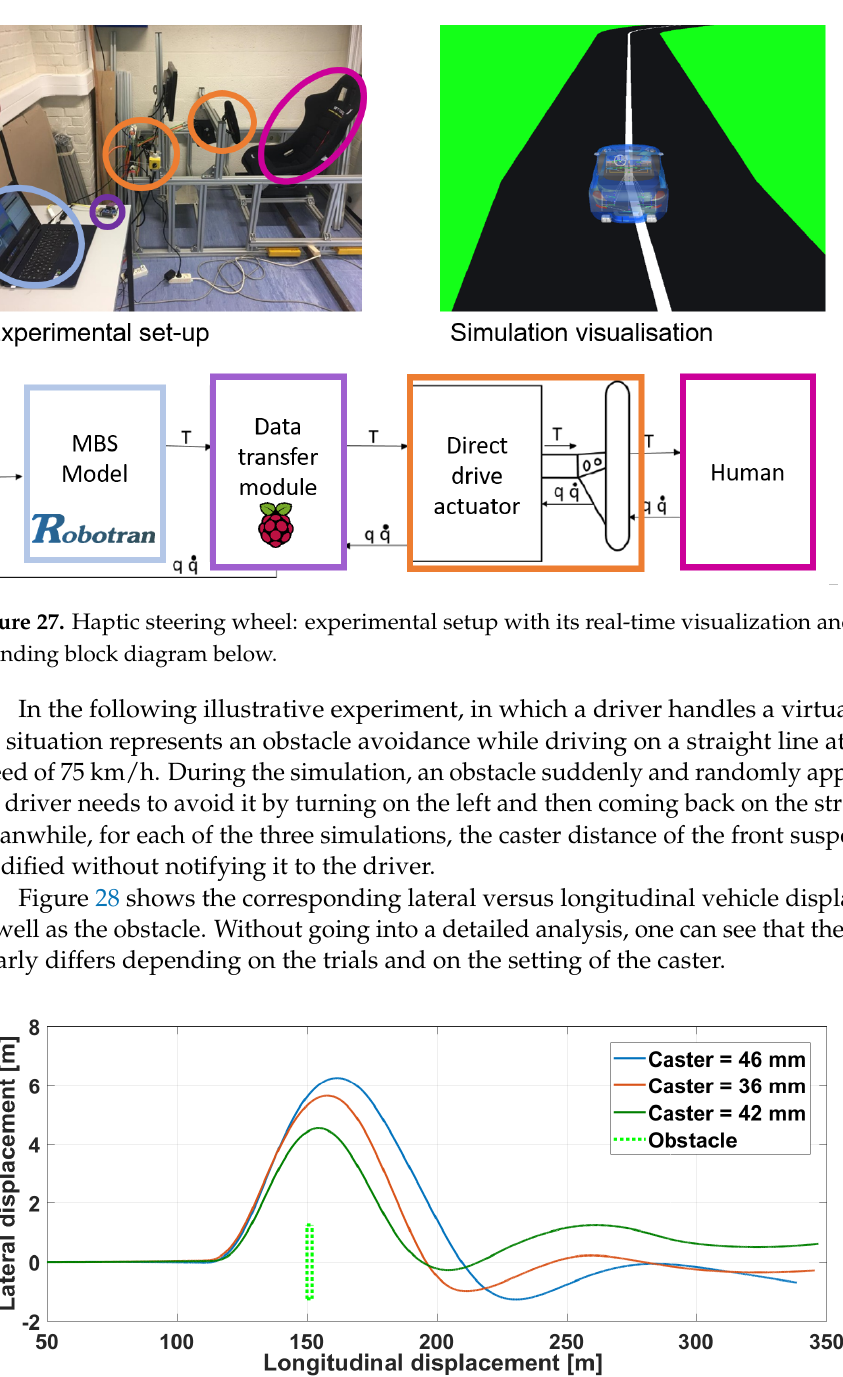
Figure 28. Haptic steering wheel: vehicle displacement on the ground with various